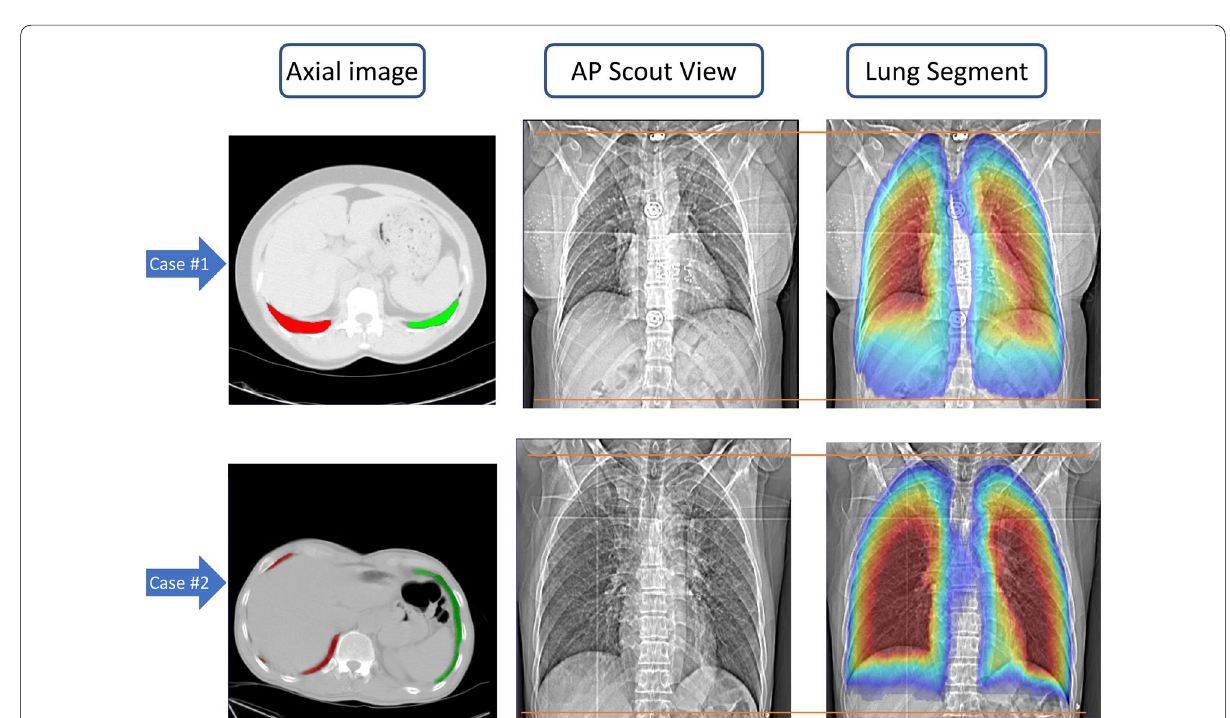
Fig. 7 Display of the axial CT image and the segmented lungs (left), AP scout view (middle) and the segmented lung overlaid on the AP scout view (right) for two clinical studies. The red line indicates the desired scan limit in the inferior direction. The colored segments show the thickness of the lung segment in any region, where the red and blue colors stand for the thicker and narrower lung segments,